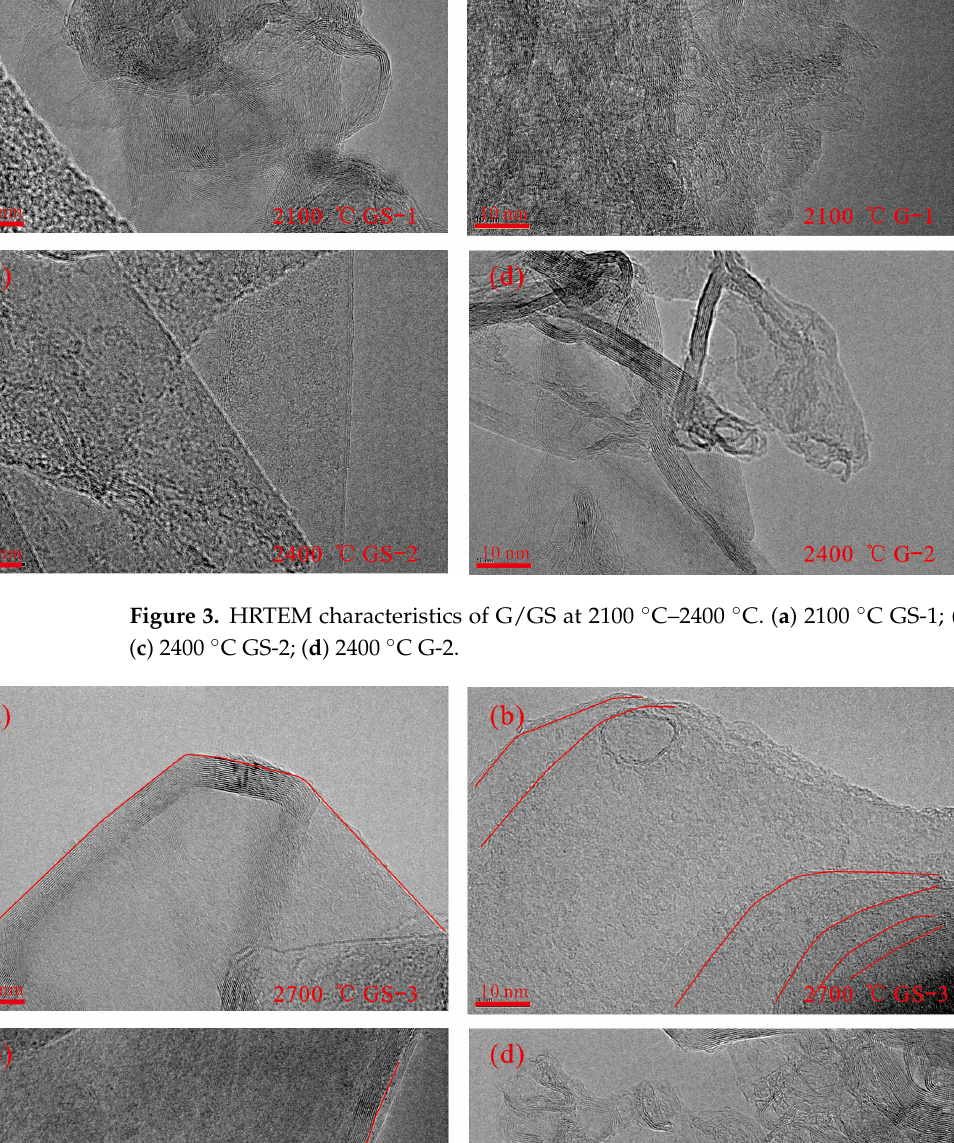
Figure 4. HRTEM characteristics of G/GS at 2700 °C. ( a ) 2700 °C GS-3; ( b ) 2700 °C GS-3; ( c ) 2700 °C G-3; ( d ) 2700 °C G-3.